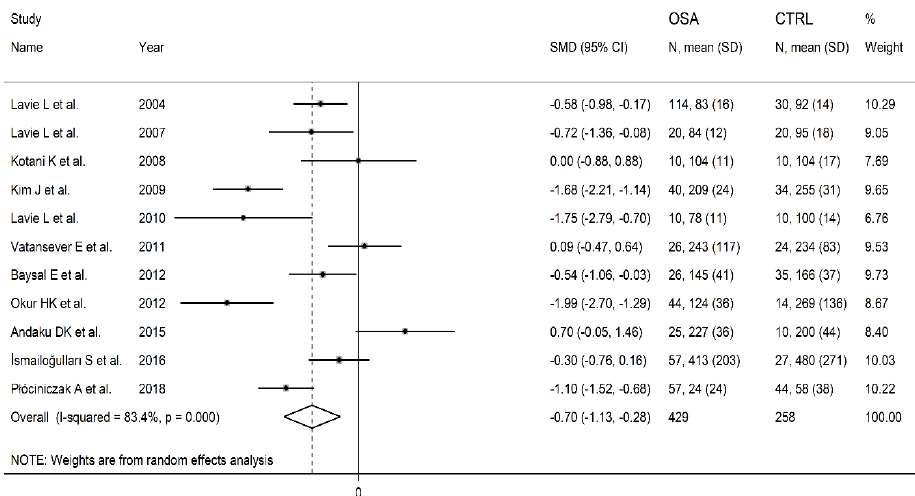
Figure 2. Forest plot of studies evaluating serum paraoxonase-1(PON-1) concentrations in patients with obstructive sleep apnoea(OSA) and controls.